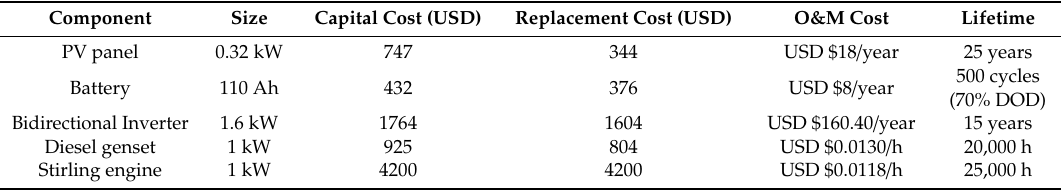
Table 2. Summary of components’